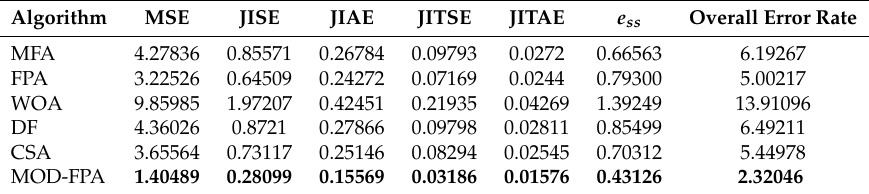
Figure 6. Speed Tracking Task for Varying Set Rotor Speed and Load Torque, at Nominal Parameters Condition. Table 8. Performance analysis for varying set rotor speed and load torque, at nominal parameters